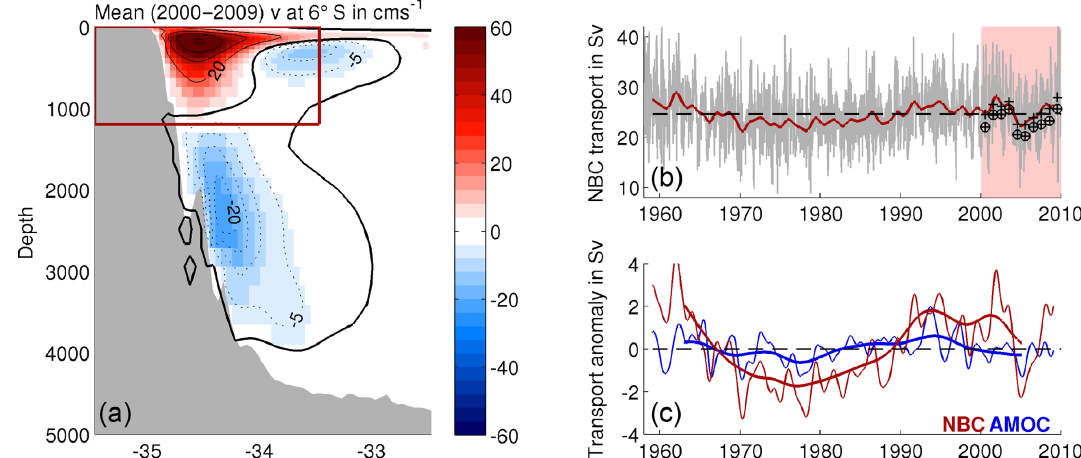
Figure 2. Simulated NBC and AMOC at 6 ◦ S. (a) Mean (2000–2009) meridional velocity v in the western tropical Atlantic; the NBC transport is defined by the integrated positive meridional (northward) velocities between the coast and 33.5 ◦ W and between 0 and 1200m of depth (red box). (b) 5d mean (grey) and interannually low-pass-filtered (red) NBC transport time series; the release period for the Lagrangian REF experiments is highlighted in light red, and annual mean Lagrangian transport estimates without (crosses) and with (crosses in circles) correction for meanders are marked. (c) Interannual (thin) and decadal (thick) NBC (red) and AMOC (blue) transport anomalies (long-term mean